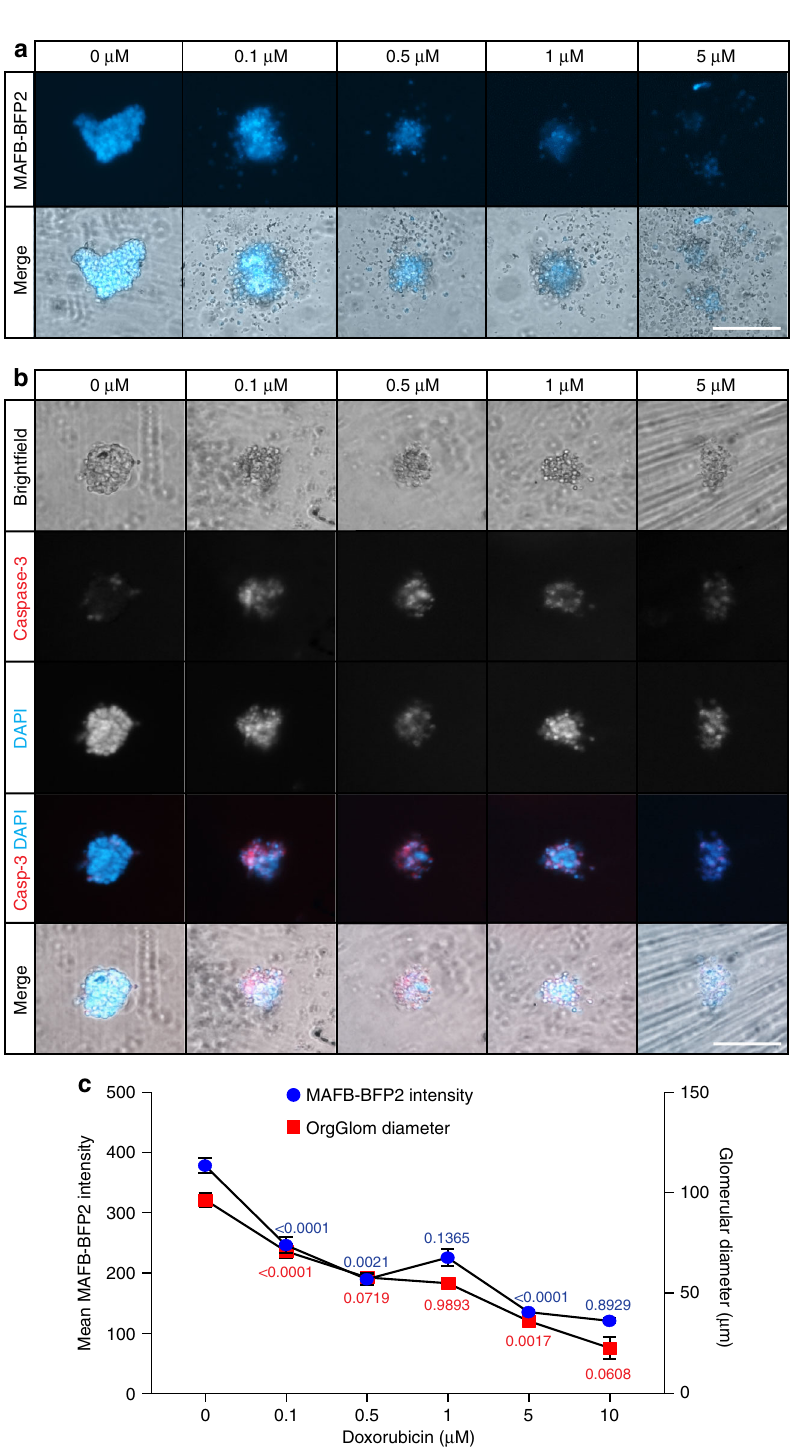
Fig. 7 Toxicity screening using cultured organoid glomeruli. a MAFB-BFP2 OrgGloms can be cultured in isolation in a 96-well format. Live imaging of glomeruli at 48 h post-treatment with doxorubicin showed a dose-dependent decrease of BFP2-reporter intensity. b Fixed glomeruli immunolabelled with Caspase-3 showed activation of this pro-apoptotic pathway following doxorubicin treatment. Scale bar 100 µ m. c Semi-quantitative analysis of BFP2- reporter intensity (blue) alongside OrgGlom diameter (red) showed a dose-dependent reduction in both glomerular diameter and BFP2-reporter intensity. One-way ANOVA p < 0.0001; error bars = SEM; signi fi cant difference between sequential doses assessed by Tukey ’ s multiple comparisons test. BFP2- reporter intensity: F -value = 80.3; DF = 5; biological replicates n = 16 per dose. OrgGlom Diameter: F -value = 60.94; DF = 5; biological replicates n =